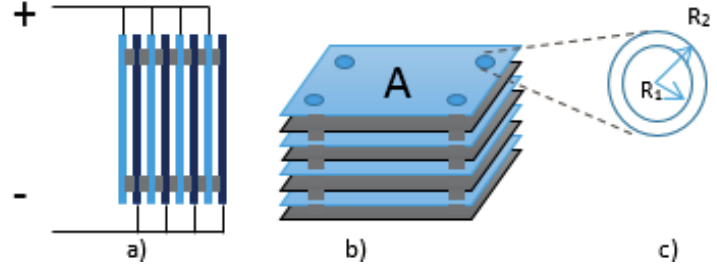
Figure 2. Outline of the capacitive sensor’s prototype. ( a ) Side view; ( b ) Perspective view; and ( c ) Circular dielectric insulators with internal (R 1 ) and external (R2) radius.